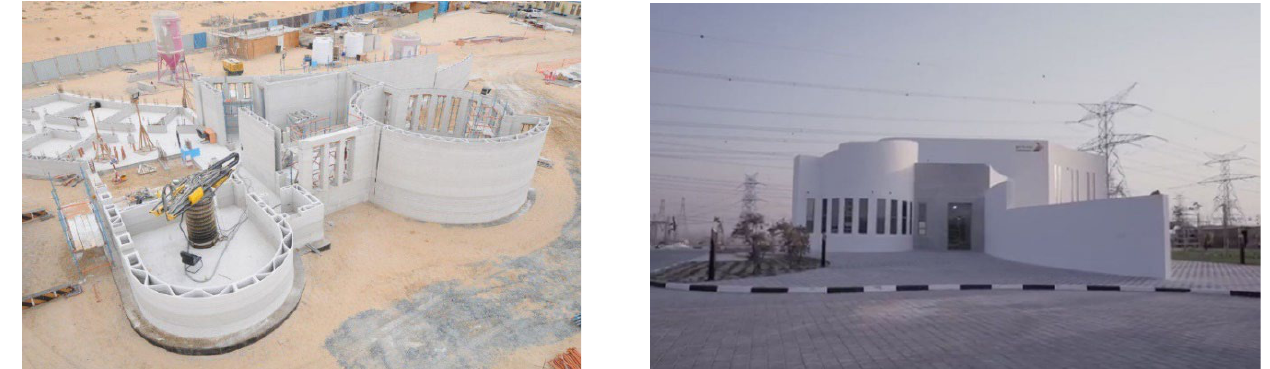
Figure 10. Largest 3D-printed two-story building in Dubai during and after construction [59].